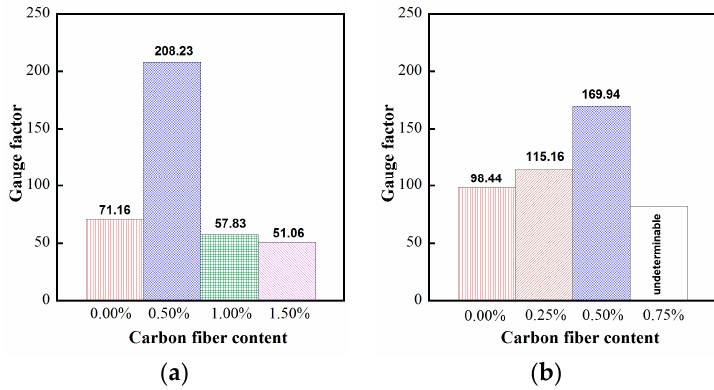
hardening response; ( b ) single crack for strain-softening response.